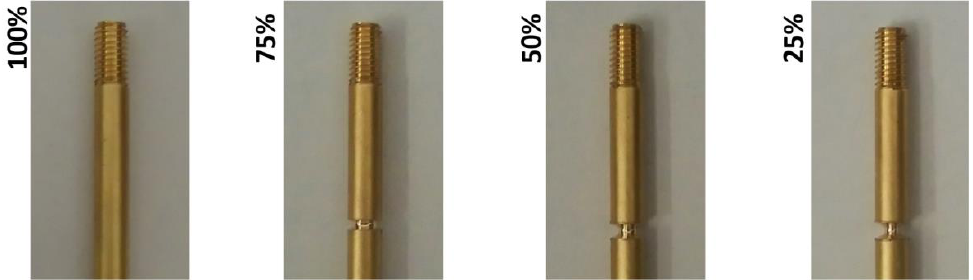
Figure 13. Decreasing the rotor bar diameter to reach 75%, 50% and 25% of its original cross-section.